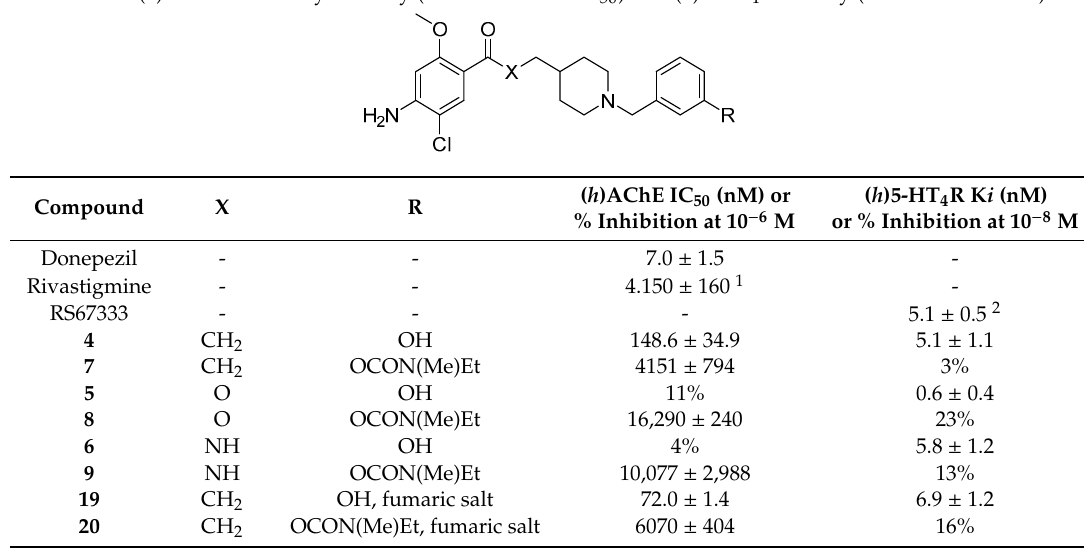
Table 1. ( h )AChE inhibitory Activity (% inhibition or IC 50 ) and ( h )5-HT 4 R a ffi nity (% inhibition or K i ).